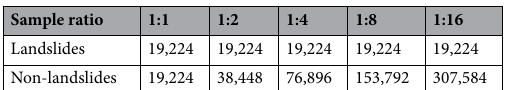
Table 5. Undersampling ratio and raster cell count statistics.